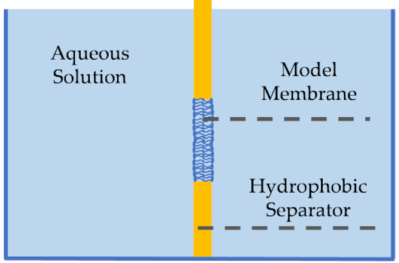
Figure 3. Pore-spanning membranes are planar lipid bilayers formed at the orifice of a hydrophobic separator between two aqueous solutions. The membrane can be achieved through the painting or folding approach. In the painting method, lipid-dispersed solvent is placed in the separator hole by painting it with a syringe or a brush. The bilayer is then formed through lipids self-orientation. In the folding method, the lipid monolayers are initially formed at the water-air interface while the orifice is higher than the water level. Then, pulling the hydrophobic separator downwards, the monolayers follow through hydrophobic bonding and the bilayer is formed in the